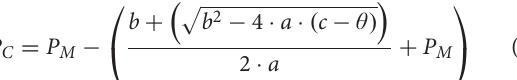
rest period participants undertook a 7 × 4-min